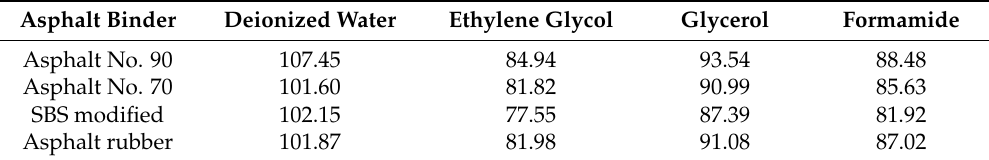
Table 3. Contact angle between the asphalts and the reference liquids at 25 ◦ C.